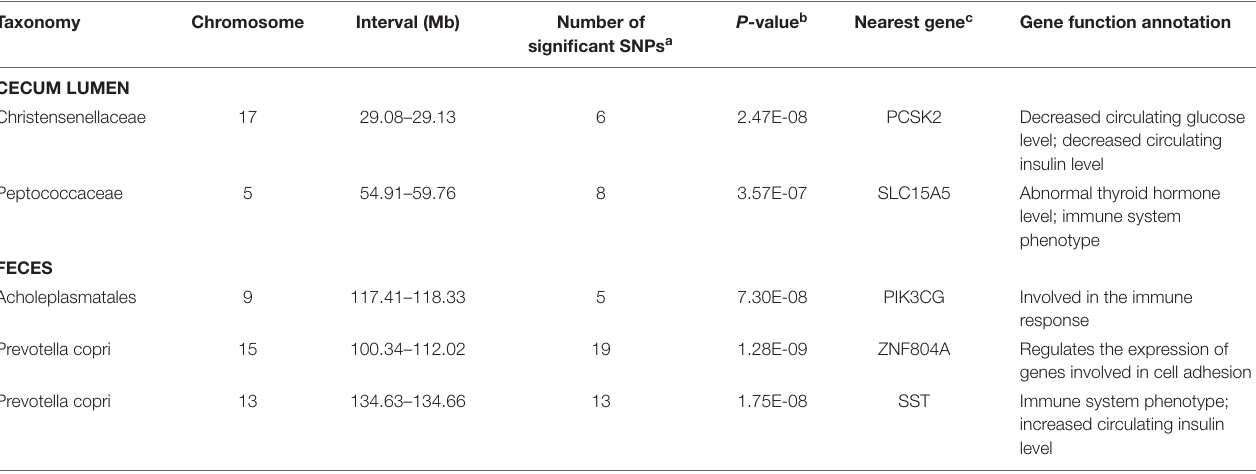
TABLE 2 | GWAS results for bacterial